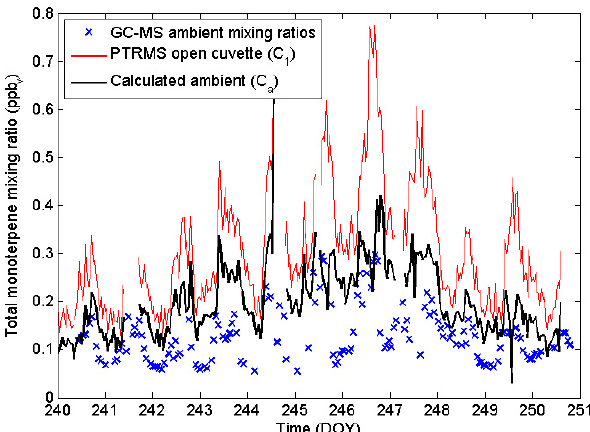
Figure 1. Comparison between the PTR-MS signal with open cu- vette (red line), the GC-MS measurements conducted in the ambient atmosphere (blue crosses) and the box model calculations of Eq.